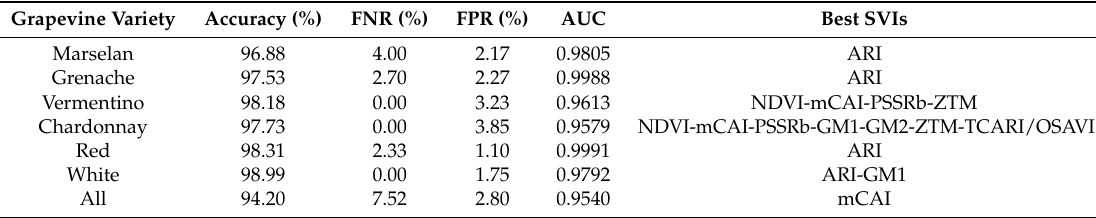
Table 7. Results of using the best SVIs in classifying different groups of spectral data acquired in the September acquisition campaign (Severity of infestation = 2).